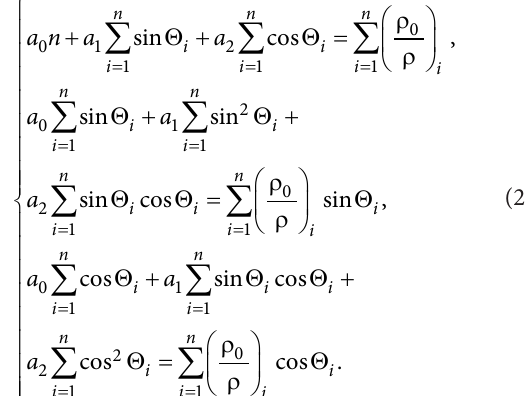
Projected value of ρ , Θ and measured value ρ, Θ 0 0 are given in Table 1. The distances are measured with the mean square error m = 5 mm, the angles Θ are measured ρ with an average quadratic error of m = 2 ′′ . θ The greatest error in the position of the most distant extreme point, example, No. 1, 3, 19, 21. S = 63.2456 m, and a table, with the accuracy of these measurements will be with generally known formula: